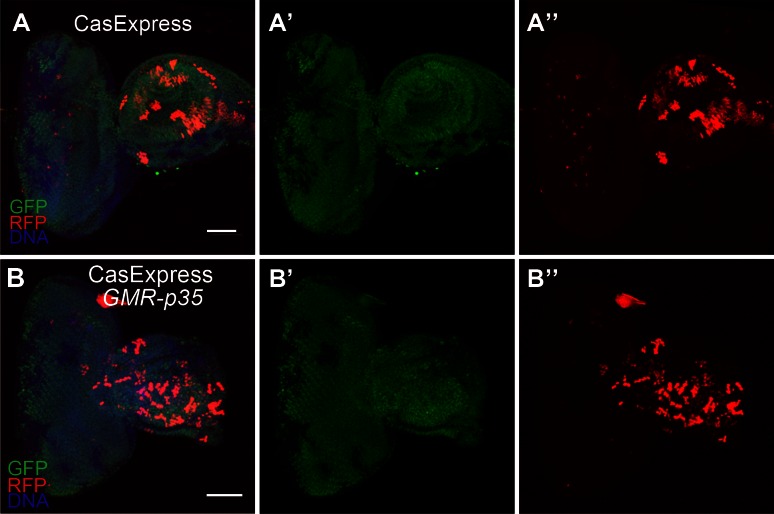
GFP and RFP expression of CasExpress in a wild type eye-antennal disc (A–A”), or one carrying the GMR-p35 transgene (B–B”).Scale bars are 100 μm.